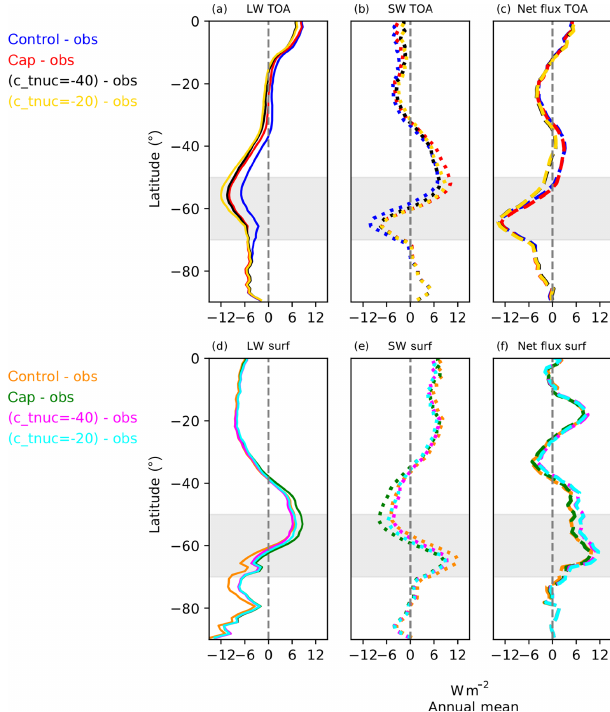
Figure 3. Similar to Fig. 2 but for the DJF season.